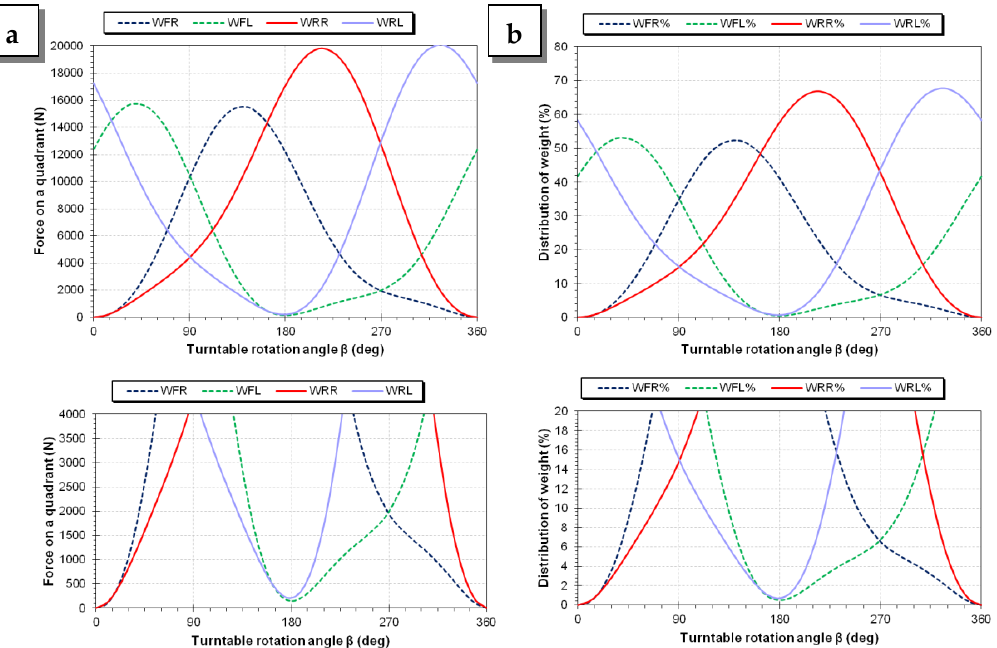
Figure 19. ( a ) forces normal to the four quadrants that support the vehicle during a complete rotation of the turntable for α = 37.73 ◦ ; ( b ) percentage decomposition of the total weight on the four quadrants / wheels for α = 37.73 ◦ . In the lower part of the picture there are two enlargements of the Cartesian planes close to the abscissae axis.